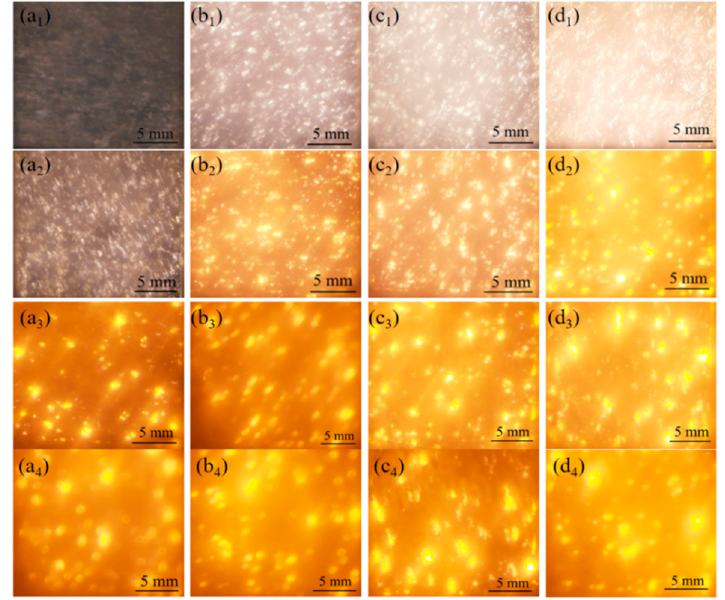
Figure 4. Discharge sparks on the surface of Al-12 Si with ( a 1 – d 1 ) 0, 15, 30, and 60 s etching treatment at the 5th min of MAO treatment; ( a 2 – d 2 ) 0, 15, 30, and 60 s etching treatment at the 10th min of MAO; ( a 3 – d 3 ) 0, 15, 30 and 60 s etching treatment at the 20th min of MAO treatment; ( a 4 – d 4 ) 0, 15, 30 and 60 s etching treatment at the 30th min of MAO treatment. Table 1. The positive voltage and layer thickness for Al-12 Si by different pretreatment and MAO time.